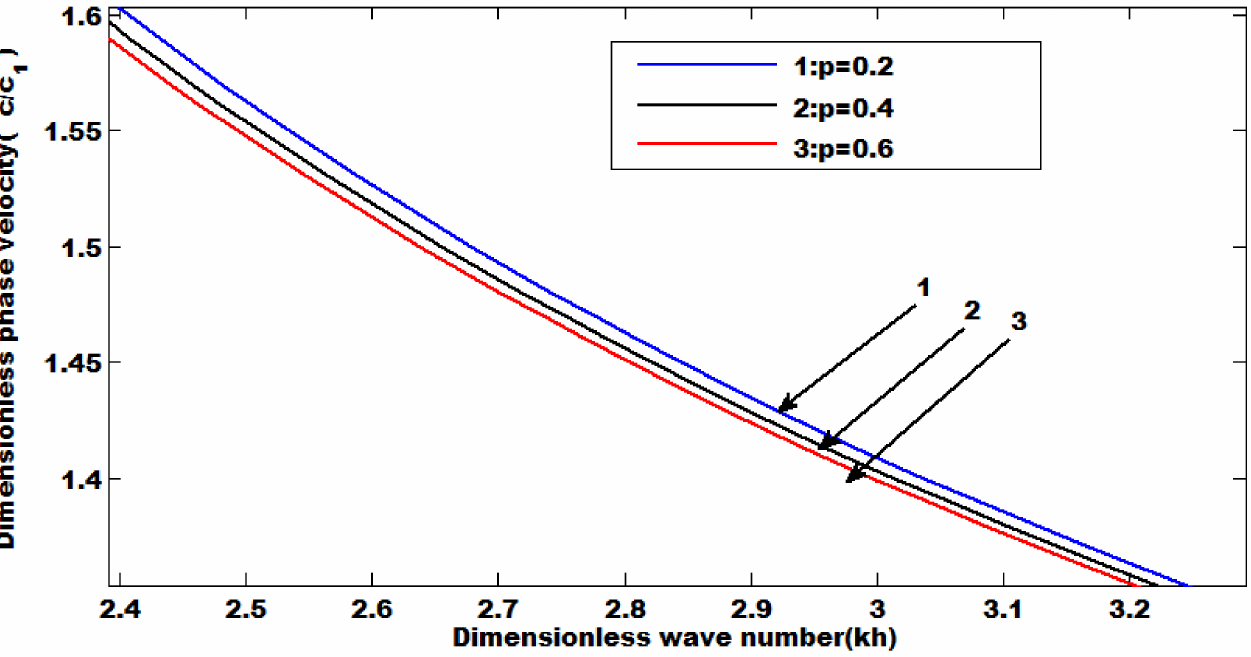
Figure 4. The phase velocity with wave number when a 1 = 0.1, β = 0.1, h = 0.04, a 2 = 0.2, m = 0.08, α =